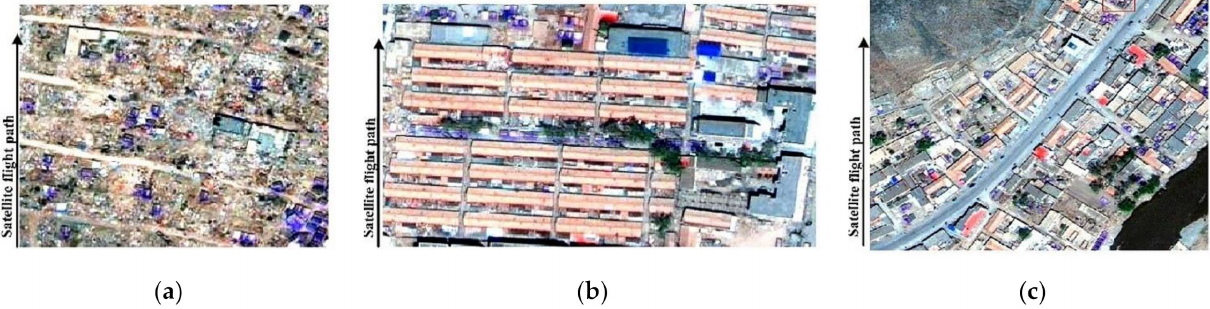
Figure 14. Optical images (data source: Google earth) of: ( a ) collapsed buildings; ( b ) orthogonally-oriented buildings; ( c ) obliquely-oriented